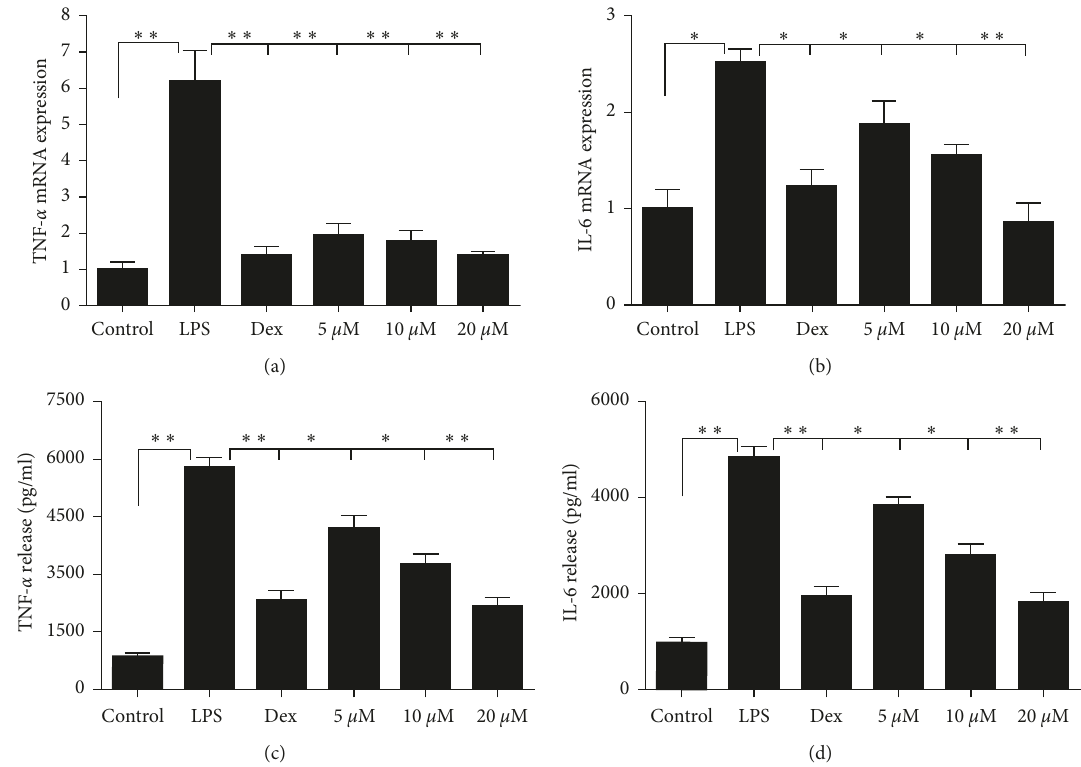
SEM and was representative of ±